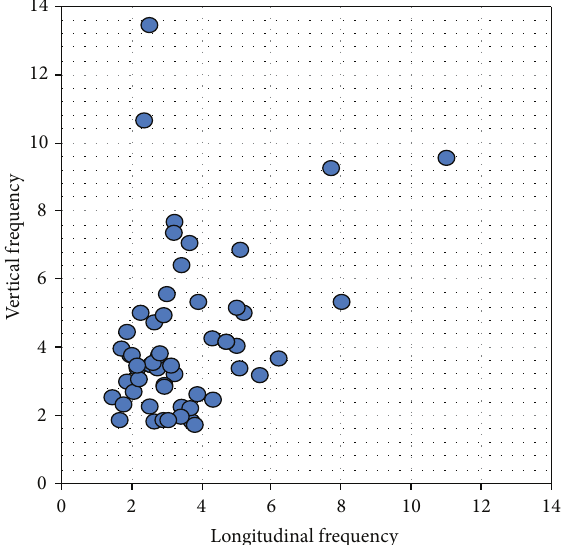
Figure 6: Correlation of V and L frequencies for all